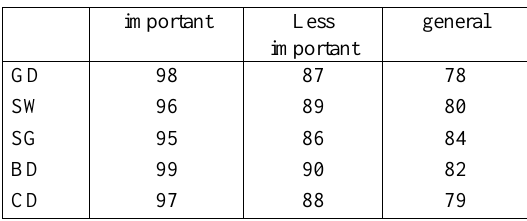
Table 5 . fuzzy consistency of geographical names.